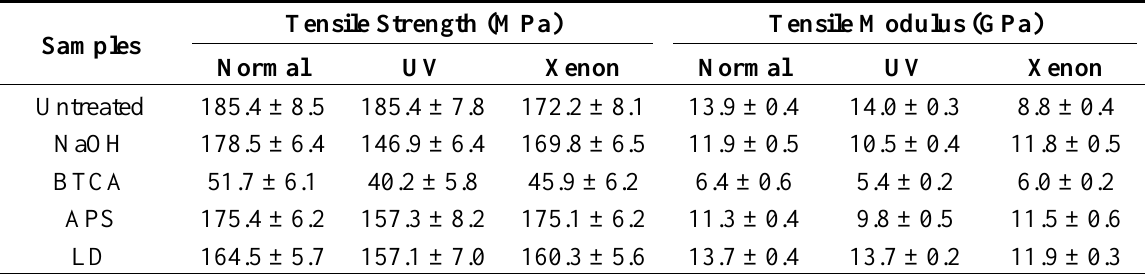
Figure 7. Flax/supersap bio-epoxy composites samples with and without treatments after aging condition: ( a ) UV radiation for 552 h; ( b ) Xenon light for 500 h. Table 5. Tension properties of hybrid flax/supersap bio-epoxy composites with different treatments in weathering